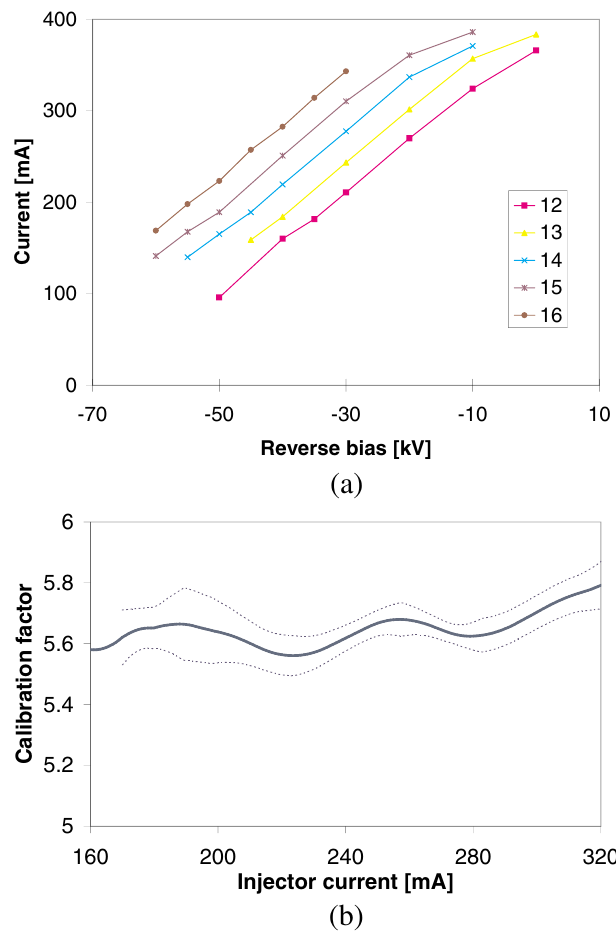
FIG. 4. (Color) (a) Measured beam current as a function of dc reverse bias voltage for extraction power supply voltages of 12– (cid:5) 940 kV ). The slope of a least-squares linear 16 kV ( V Marx regression through the points of (a) as a function of beam current provides the predicted calibration factor shown in (b). The calibration factor is the ratio of the amplitude of the gate voltage pulse to the extraction power supply voltage. The dashed lines indicate the standard error of the linear regression. At 180 mA the predicted calibration factor is 5.65 and the standard error is 0.07 or